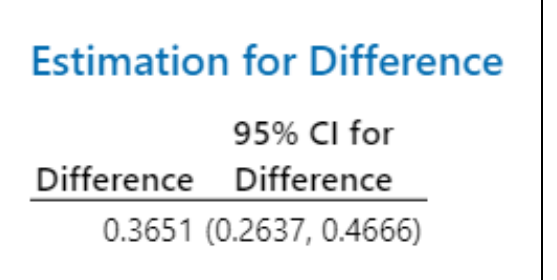
Figure 7. Estimation for differences of ∆ CI absol . and the associated 95% confidence interval. Fraun- hofer IPA.